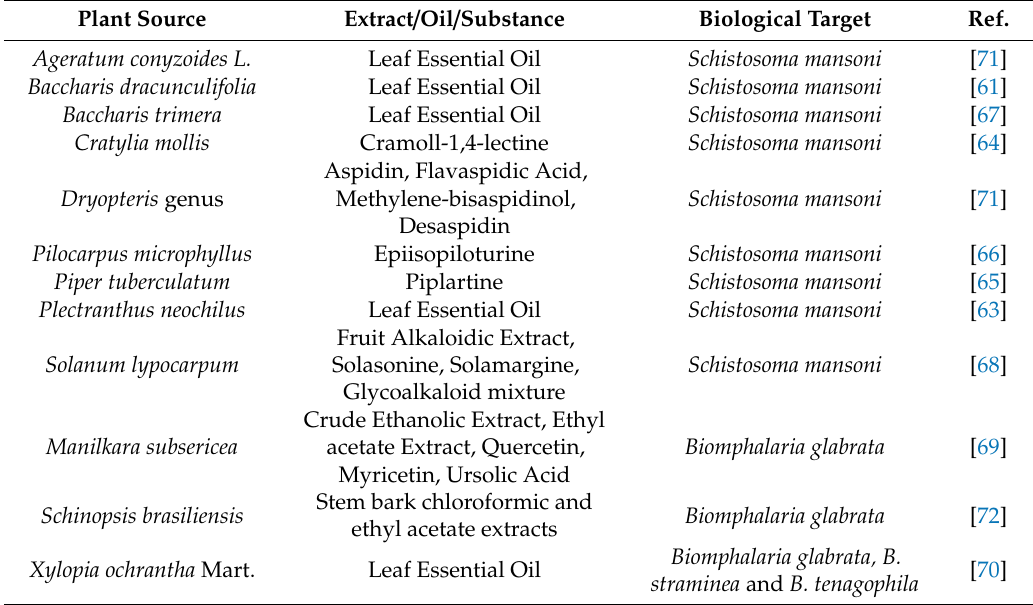
Table 2. Extracts, oils, and substances from the Brazilian plant origin with antischistosoma or molluscicide